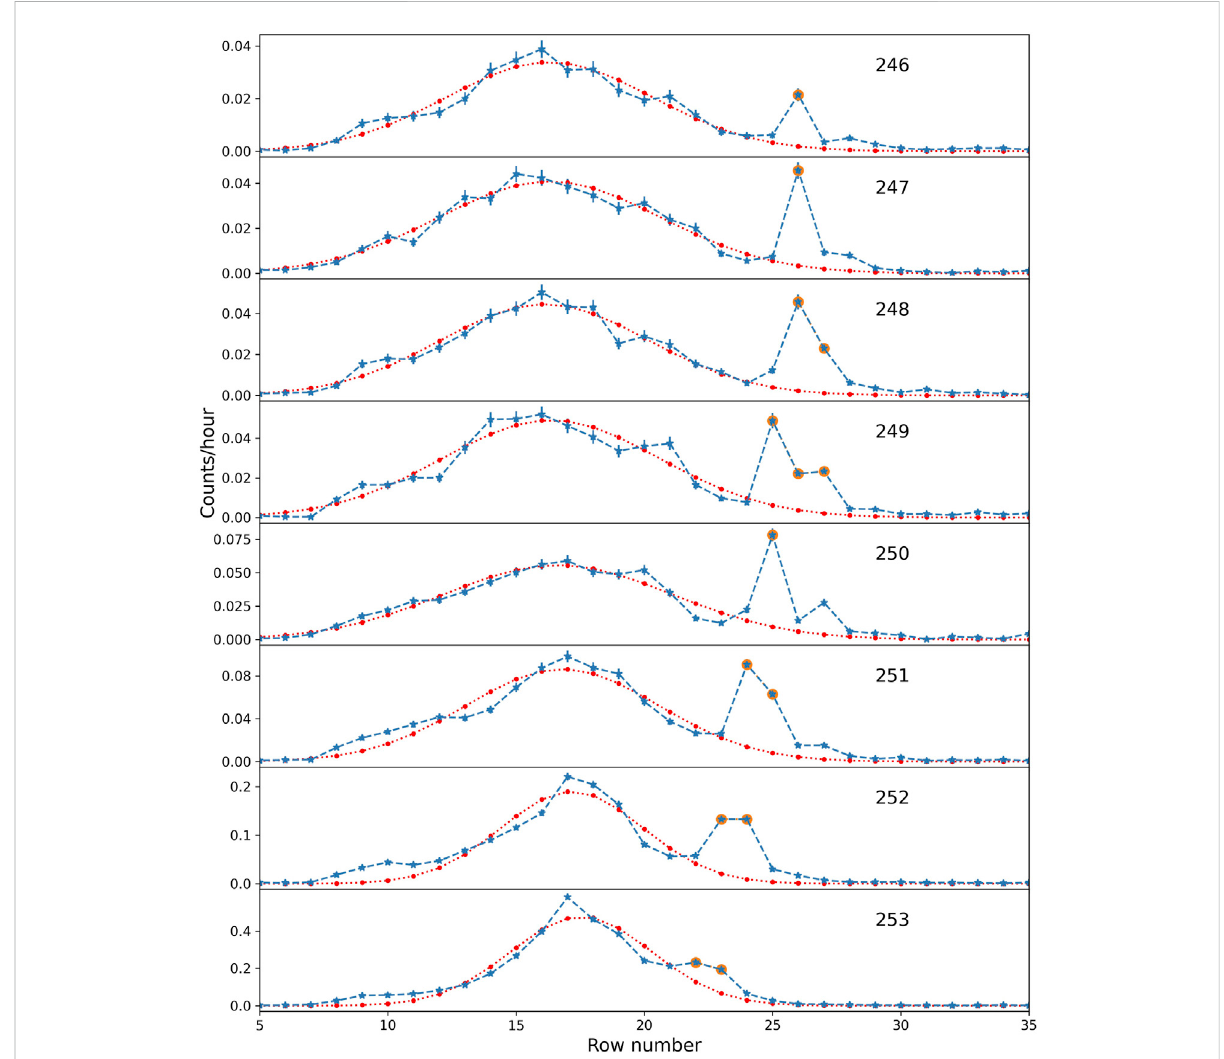
FIGURE 4 Thedistributionofcount ratesalongthe Y -axisbetweencolumns246and 253of “ Xmasplot ” .The bluedashedlinesarethemeasurementsand the red dashed lines are the fi ttedGaussian distributions. The error bars are statistical uncertainties. The difference betweenthe orange dots and the background gives the albedo proton-contributed count